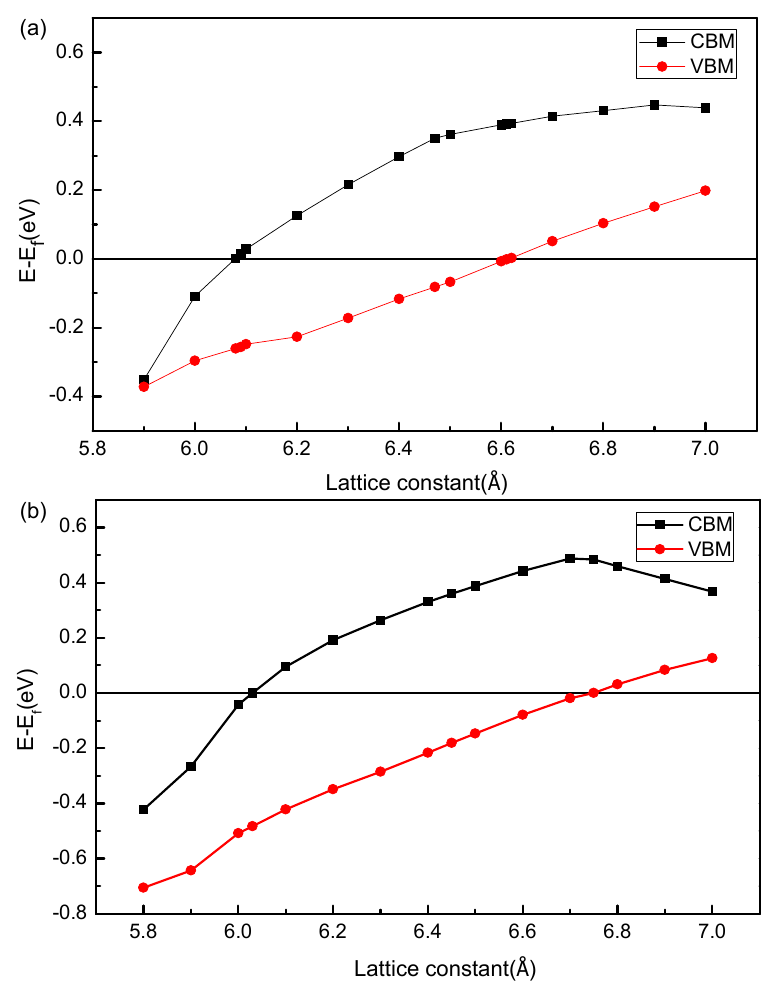
Figure 7. Conduction band minimum (CBM) and valence band maximum (VBM) in the spin-down channel as a function of lattice constant (US) for ZrRhTiAl ( a ) and ZrRhTiGa ( b ).